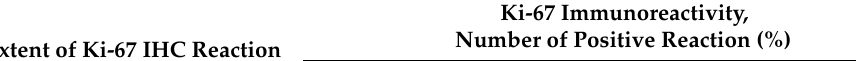
Table 1. Expression of Ki-67 in control ( n = 5) and morning and evening PFK15-treated groups ( n = 6). A total score of 0 was considered as negative, 1–3 as weak, 4–6 as moderate, and 8–12 as strong reaction. Ki-67 Immunoreactivity, Number of Positive Reaction (%) Extent of Ki-67 IHC Reaction Negative Weak Moderate Strong Control group 0 0 0 100 Morning group 0 0 50 50 Evening group 0 0 17 83 Regressive changes of tumor parenchyma were more pronounced in PFK15-treated groups as compared with controls and were found in the range 11–25% of the area in all cases. In the treated mice, the regressive changes were identified in the lowest range (1–10% of the area) in 33% in the morning group and in 17% cases in the evening group. In the next range of regression (26–49%), 50% cases were identified in the morning group and 17% cases in the evening group. The most prominent regressive changes ( ≥ 50% of the area)